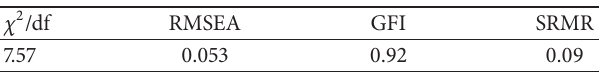
Table 3: Indices of the model